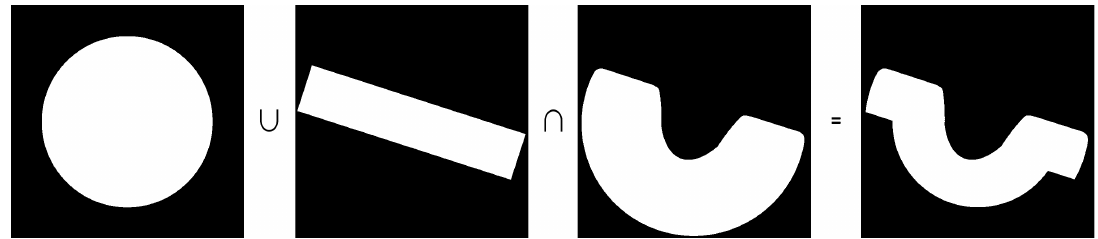
Figure 2. Generation of the region-of-interest orthoframe